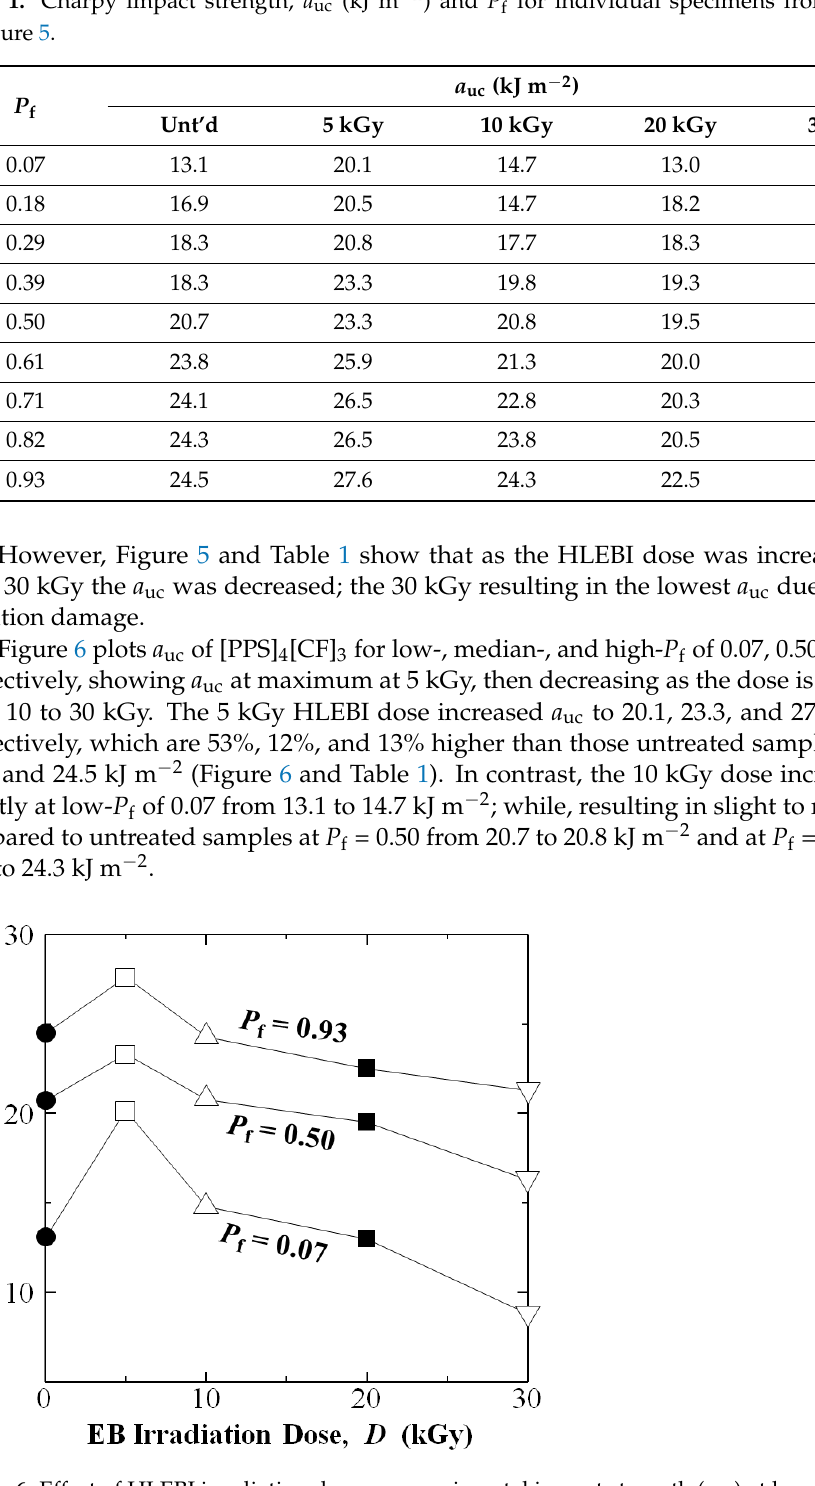
Figure 6. Effect of HLEBI irradiation dose on experimental impact strength ( a uc ) at low- ( P f = 0.07), median- (0.50), and high- (0.93) fracture probabilities for untreated and HLEBI-irradiated [PPS] 4 [CF] 3 samples, respectively.